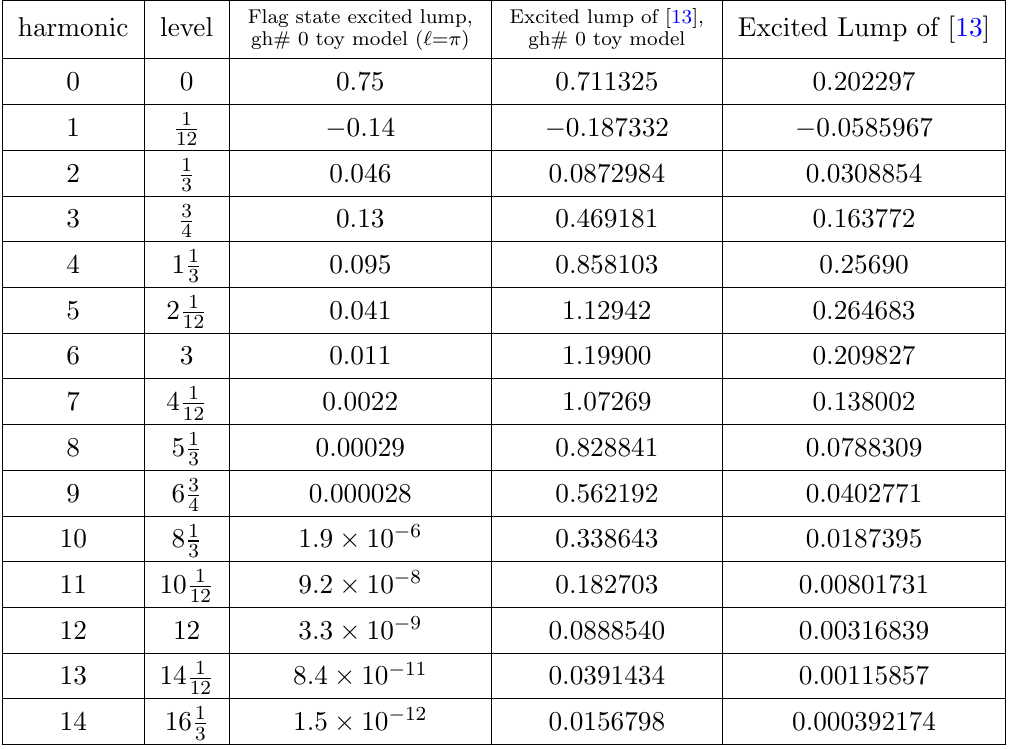
Table 3 . Coe(cid:14)cients T n of the n th exponential harmonic of the lump constructed from excited p twist (cid:12)elds at R = 2 3.